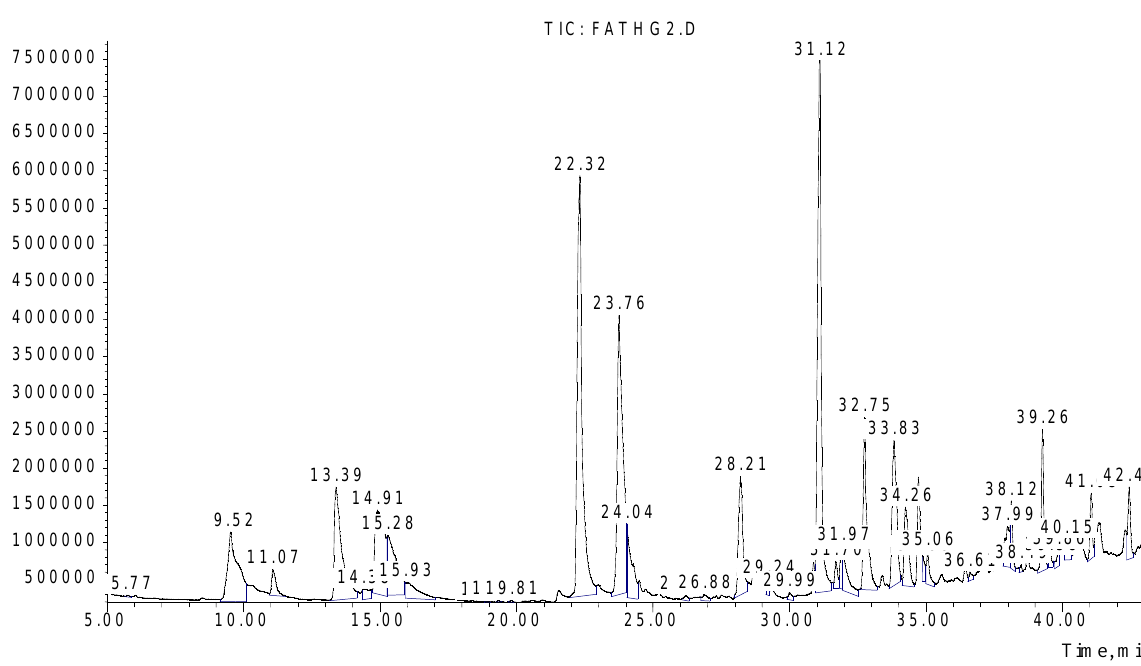
Fig. 4. Chromatographic profile of methyl esters of carboxylic acids of Veronica teucrium flowers